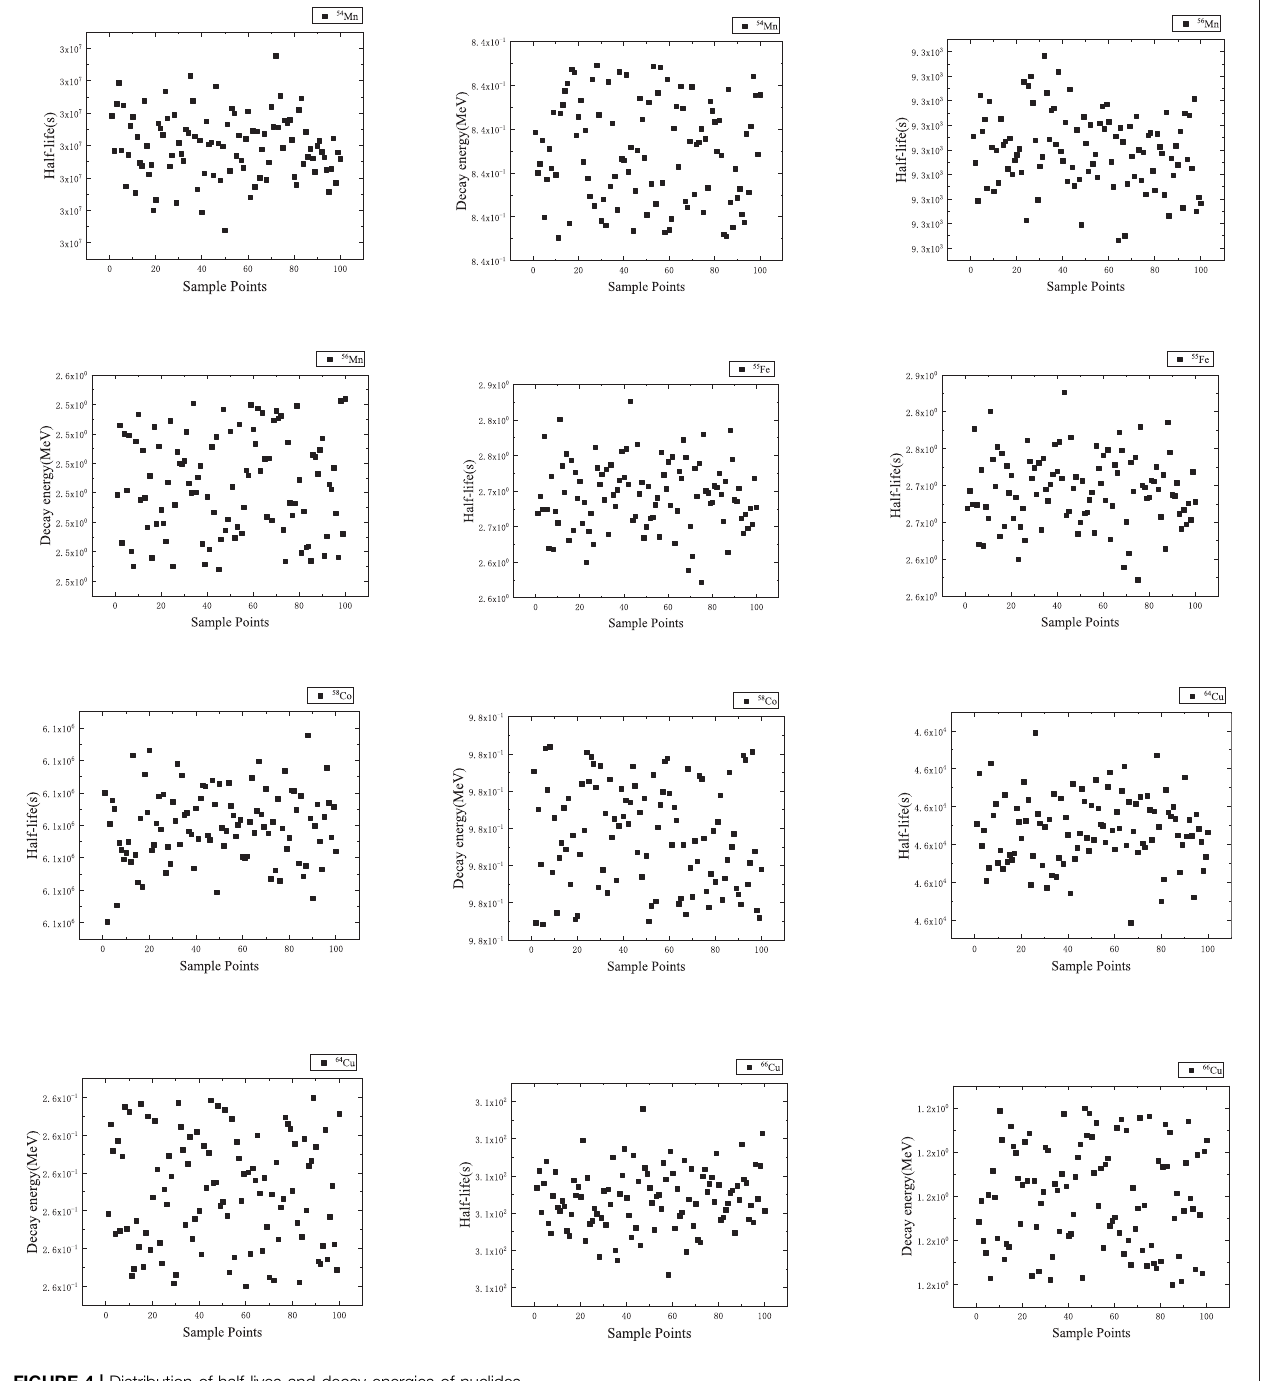
FIGURE 4 | Distribution of half-lives and decay energies of